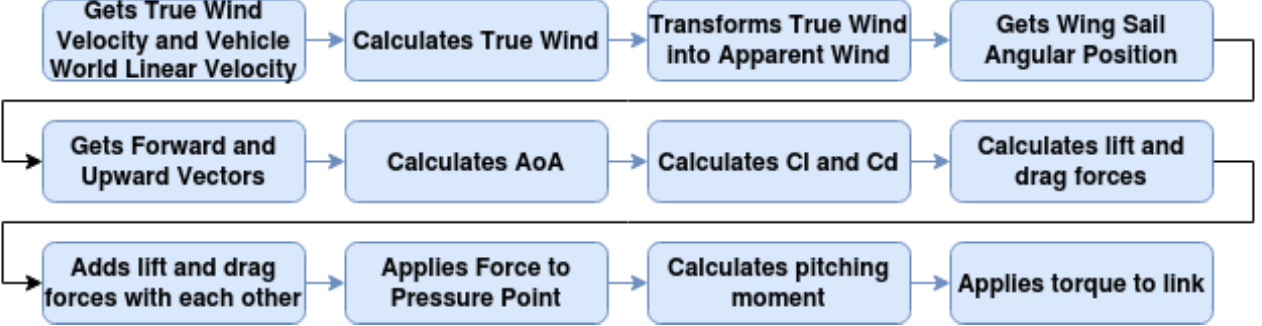
Figure 5. liftdragplugin